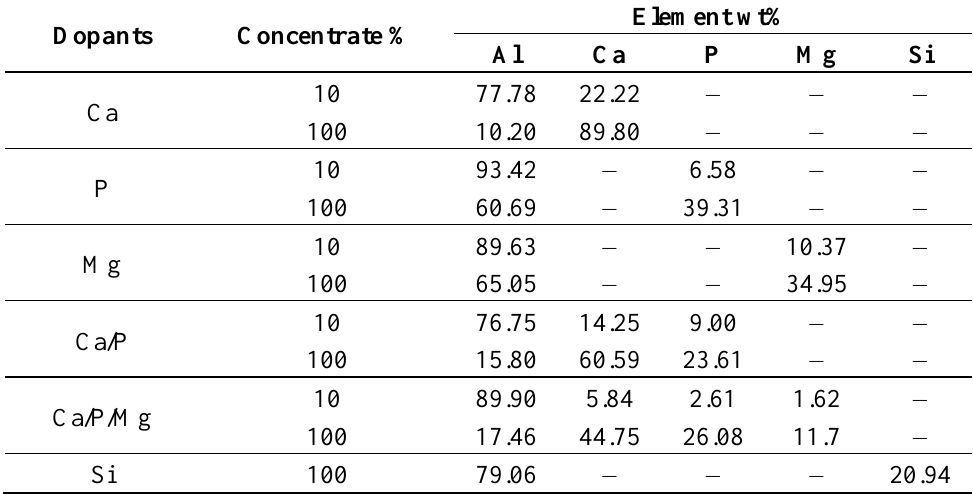
Table 3. EDS composition results showing dopant present on alumina